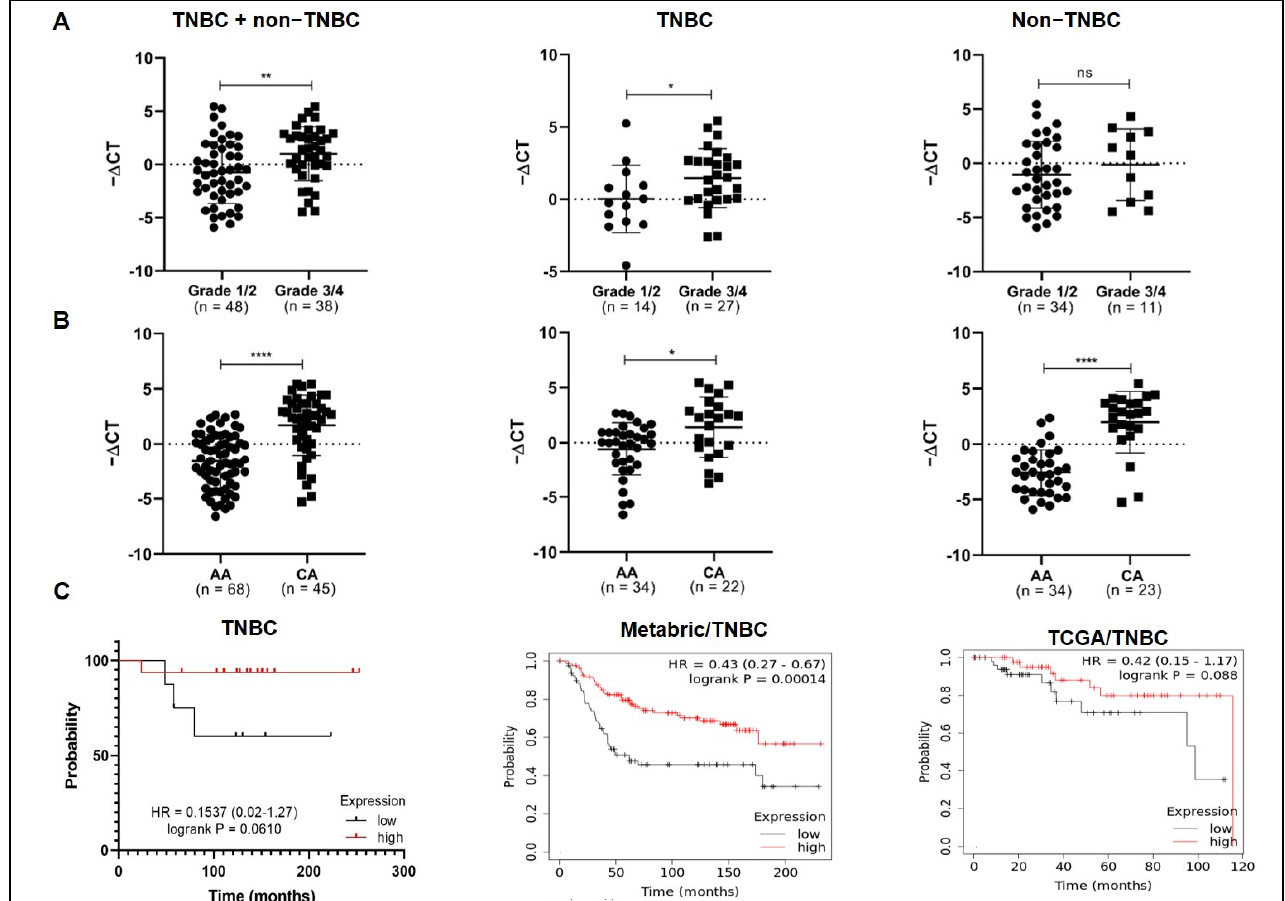
Figure 2. Association of miR-150-5p expression levels with tumor grade, ethnicity, and overall survival in TNBC. Relationship between miR-150-5p expression levels and tumor grade ( A ) and ethnicity ( B ) in the entire cohort and in the TNBC and non-TNBC subgroups; significance was determined using the Mann–Whitney U test. ( C ) Survival analysis of patients with TNBC ( left ) and of the METABRIC ( middle ) and TCGA ( right ) cohorts. * p < 0.05; ** p < 0.01, **** p < 0.0001; ns: not